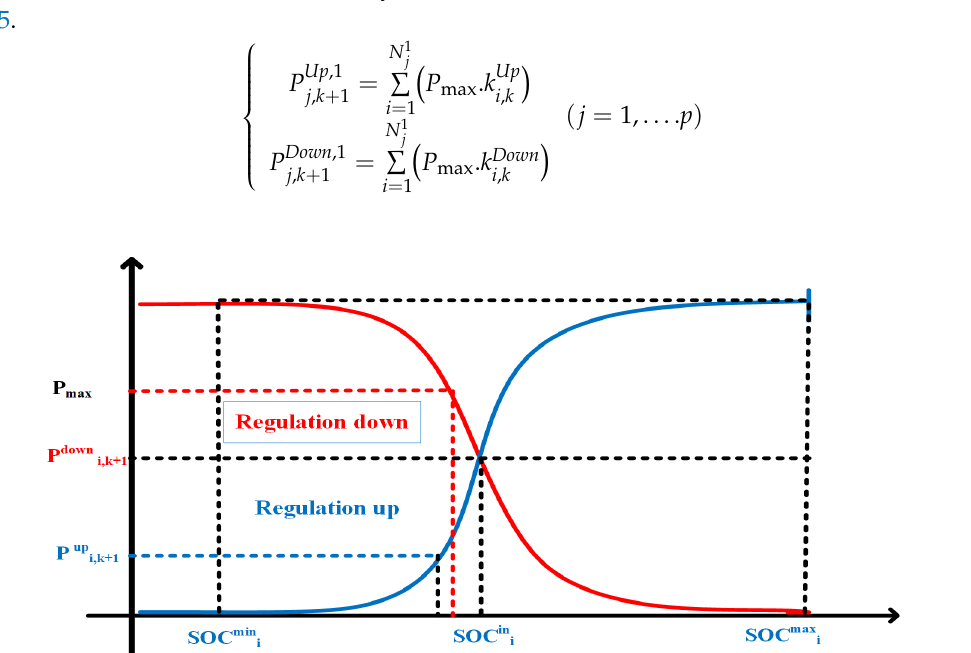
Figure 5. Expected state of charge (SOC) of the electric vehicles (EVs) battery, considering V2G power.